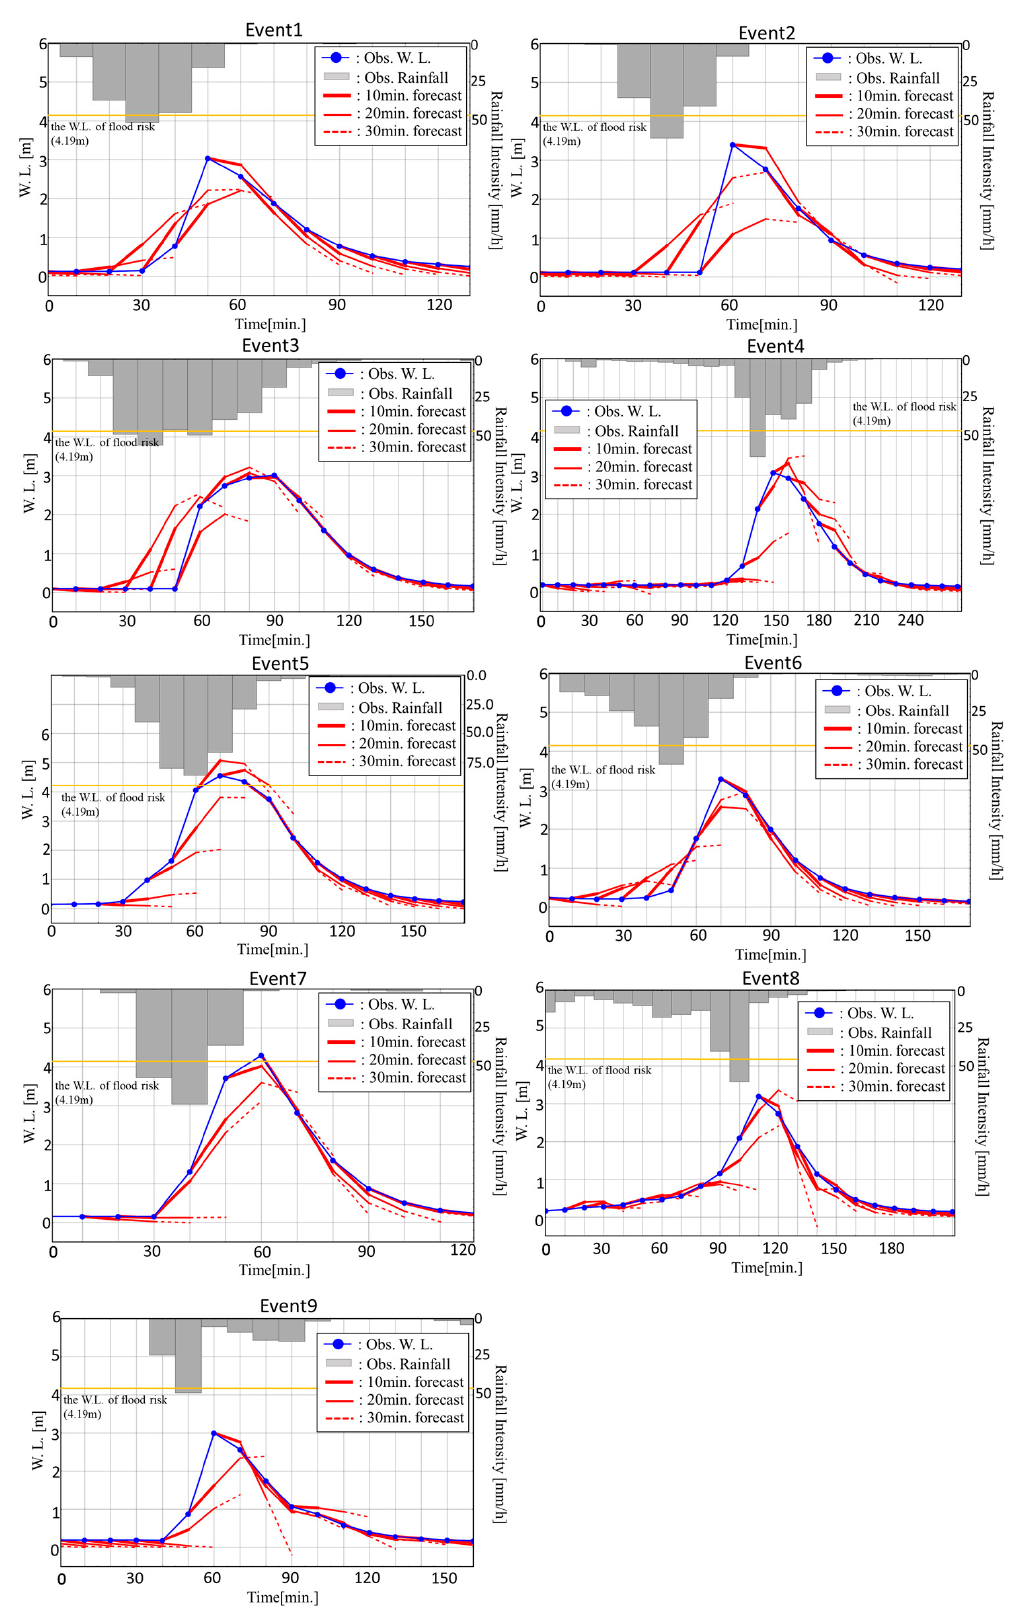
Figure 6. forecasted water level results up to 30 min ahead for all events. Figure 6. Forecasted water level results up to 30 min ahead for all